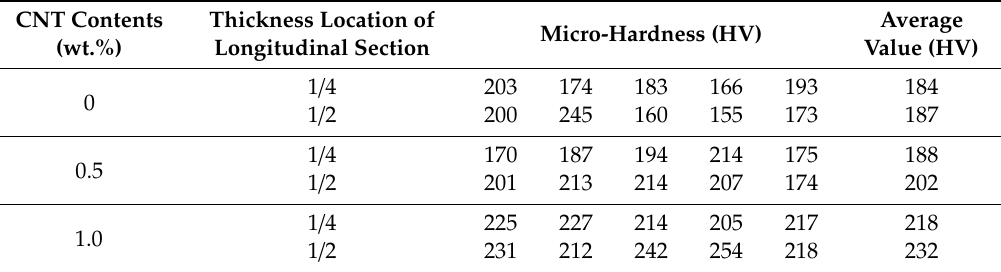
Figure 4. The microhardness of the composites with different CNT contents. Table 2. Microhardness of the composites with di ff erent CNT